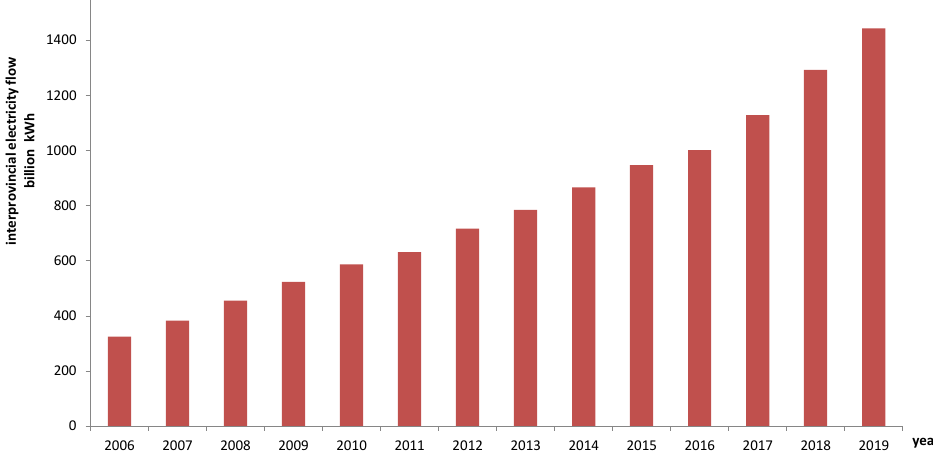
Figure 3. Size of Chinese inter-provincial electricity flow from 2006 to 2019 [44].